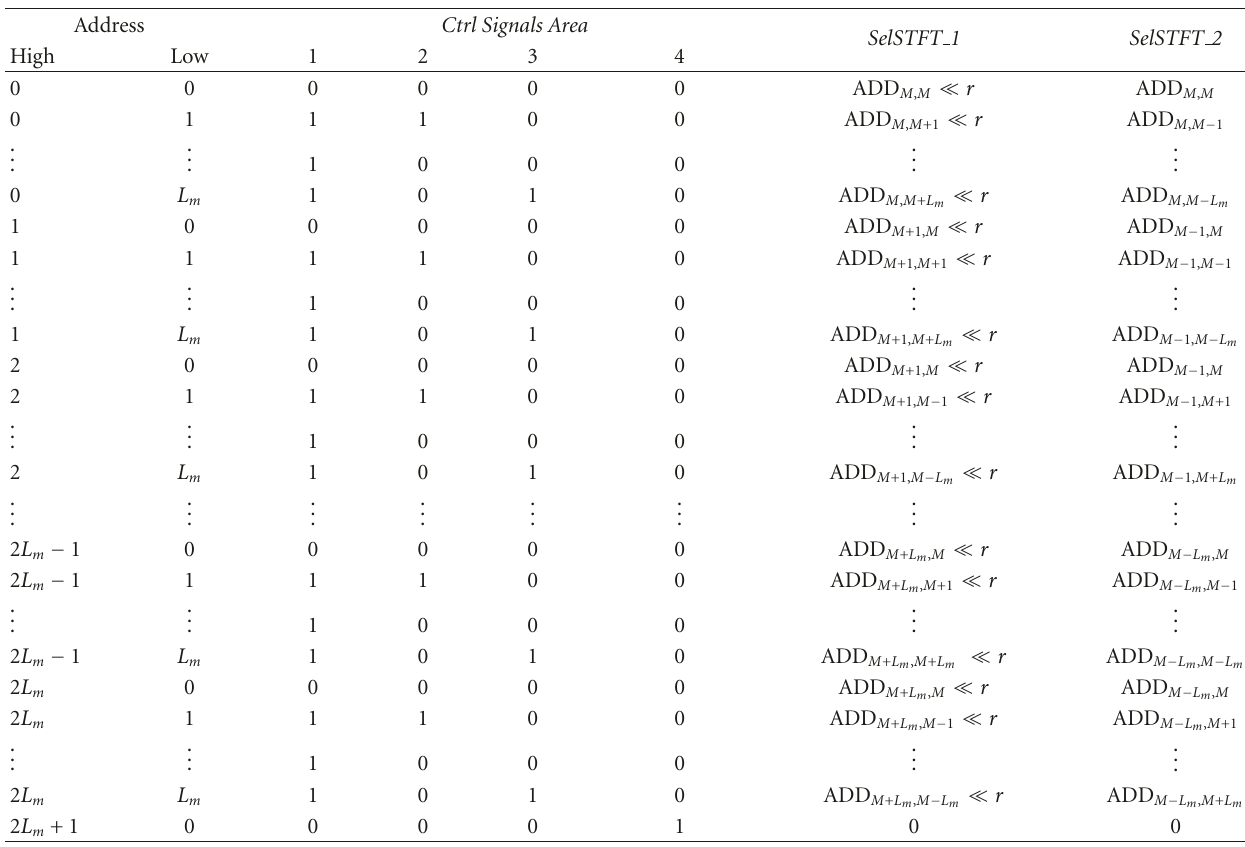
Table 3: Content of LUT memory locations for given L m . ADD M , M denotes address of central element of the convolution window register block, symbol (cid:8) denotes shift left logical operation and r = Length( SelSTFT 1 ). Control signals area contains following bits: (1) SHLorNo ,